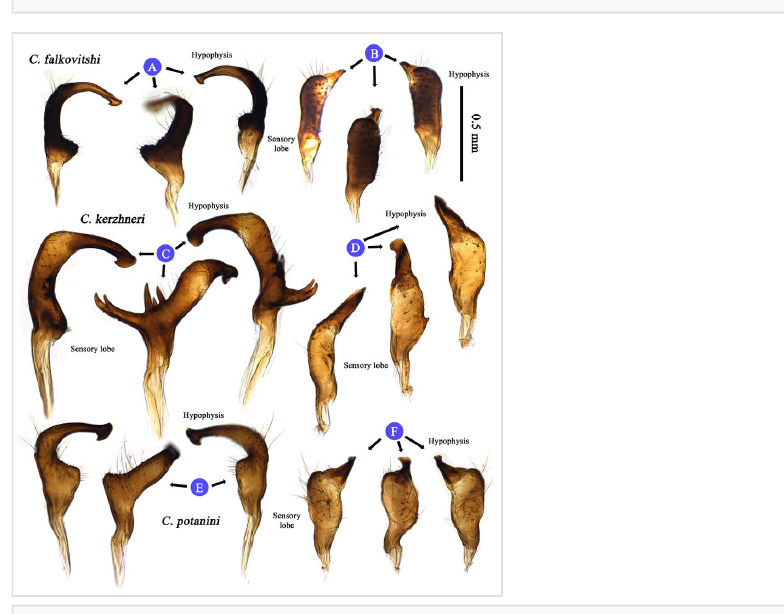
Figure 2. Male genital structure (Endosoma) of Korean Castanopsides species (A–B: C. falkovitshi ; C– D: C. kerzhneri ; E–F: C. potanini ).